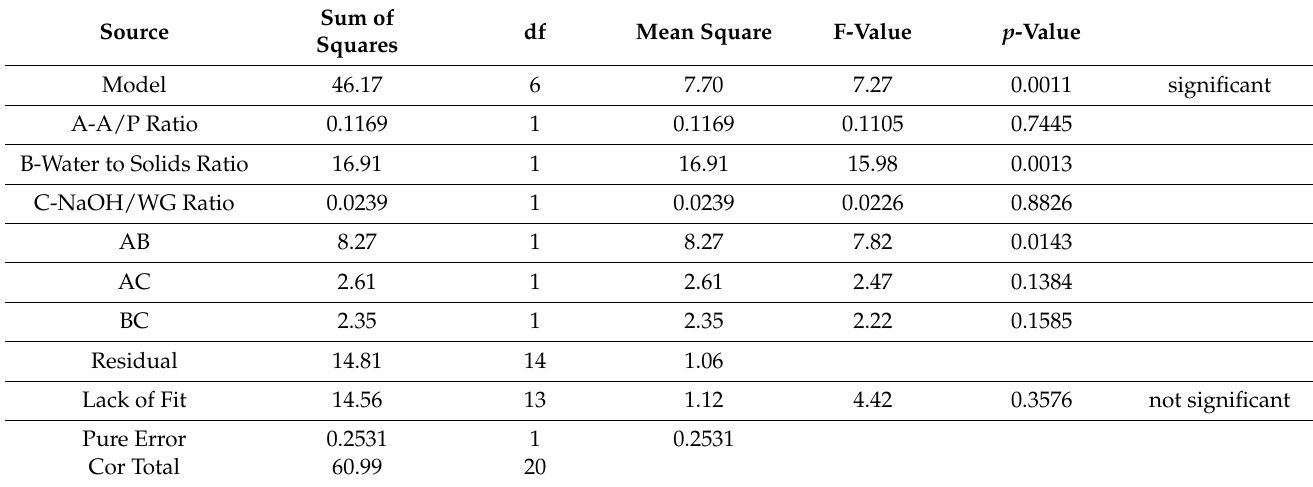
Table 9. ANOVA for reduced 2FI model (Response 1: initial setting time).